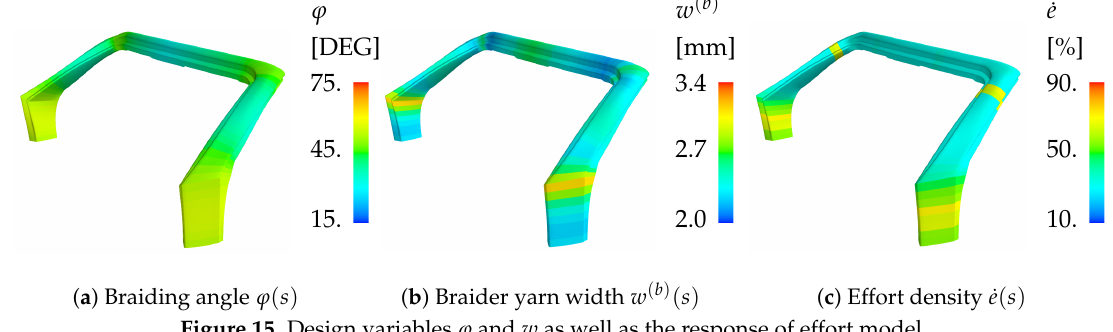
Figure 15. Design variables ϕ and w as well as the response of effort